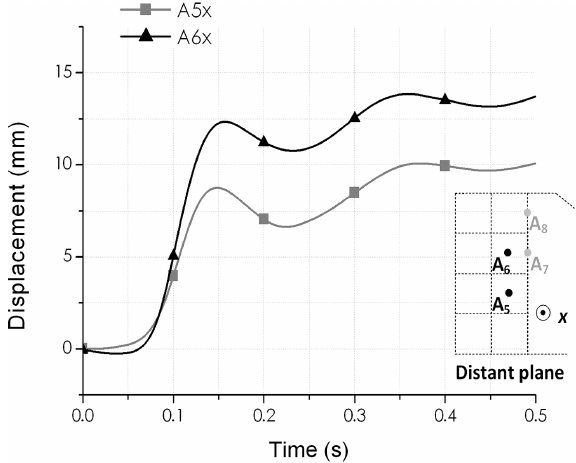
Figure 12. Displacements in the middle of the kernel, in the distant plane, along the x axis.